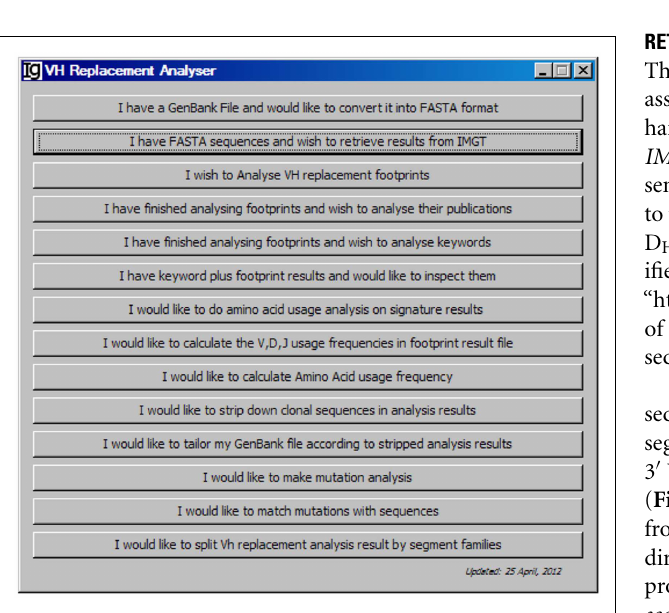
FIGURE 2 |The front page of theV H replacement footprint analyzer-I (V H RFA-I) program .TheV H RFA-I program contains multiple functional modules as listed as clickable bars on the front